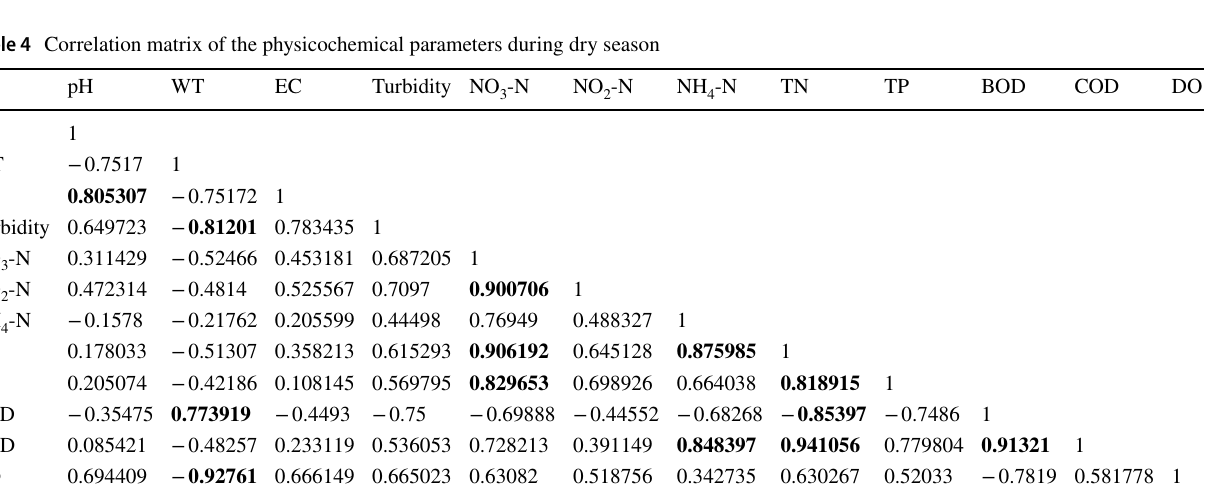
Bold values indicate the correlation is significant at the